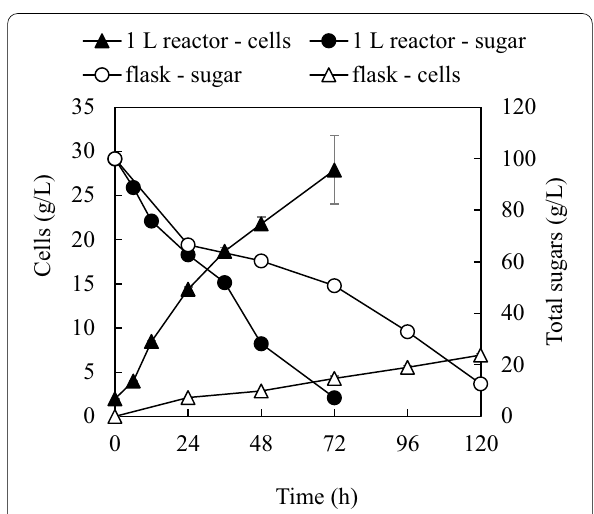
Fig. 3 Comparison of cell growth and sugar consumption in shake flasks and 1 L bioreactor. Total nitrogen, 1.65 g/L and equivalent to 10 g/L NaNO 3 (with addition of only 4.4 g/L exogenous NaNO 3 ); total phosphorous, 0.40 g/L and equivalent to 1.8 g/L Na 2 HPO 4 (no exogenous